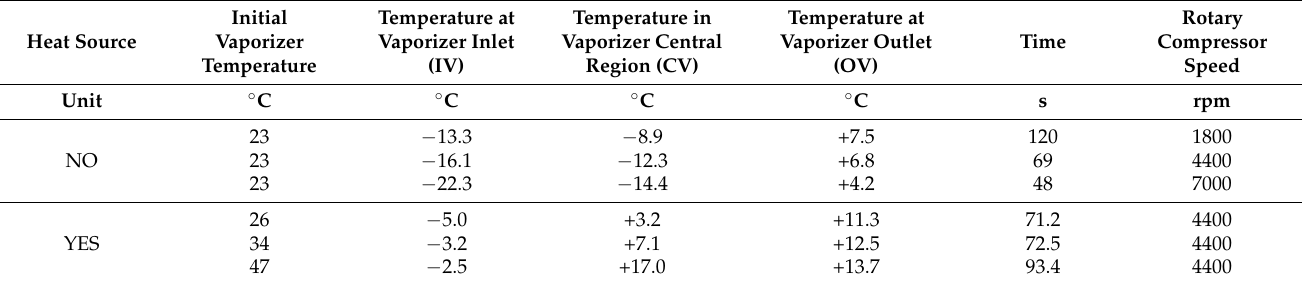
Table 5. Experimental parameters in the vaporizer